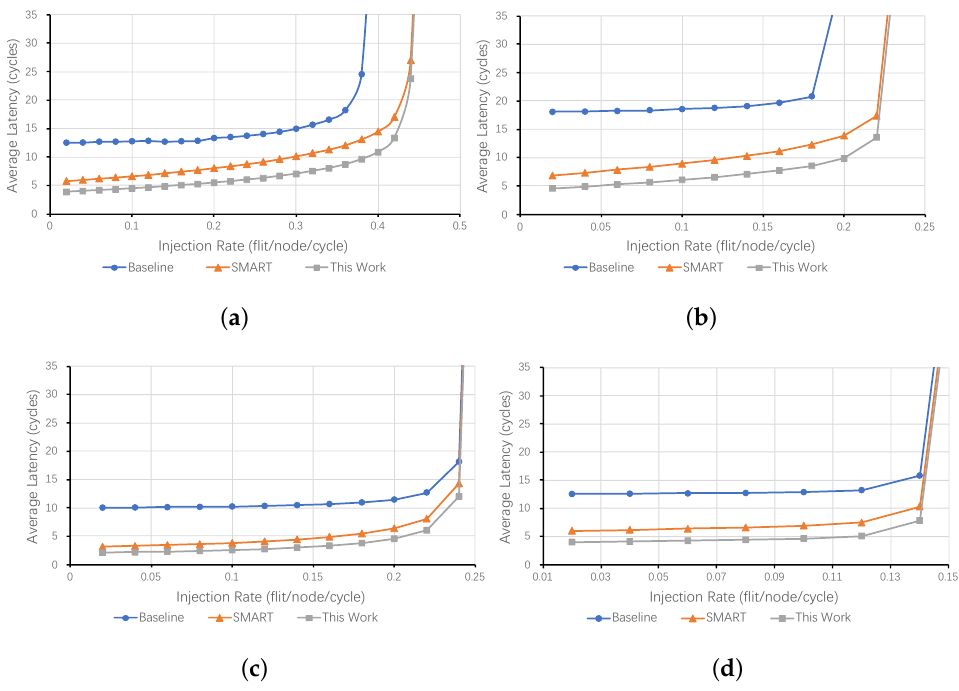
Figure 9. Average Latency in 8 × 8 Mesh Network. ( a ) Uniform Random, ( b ) Bit Complement, ( c ) Tornado, and ( d ) Transpose.